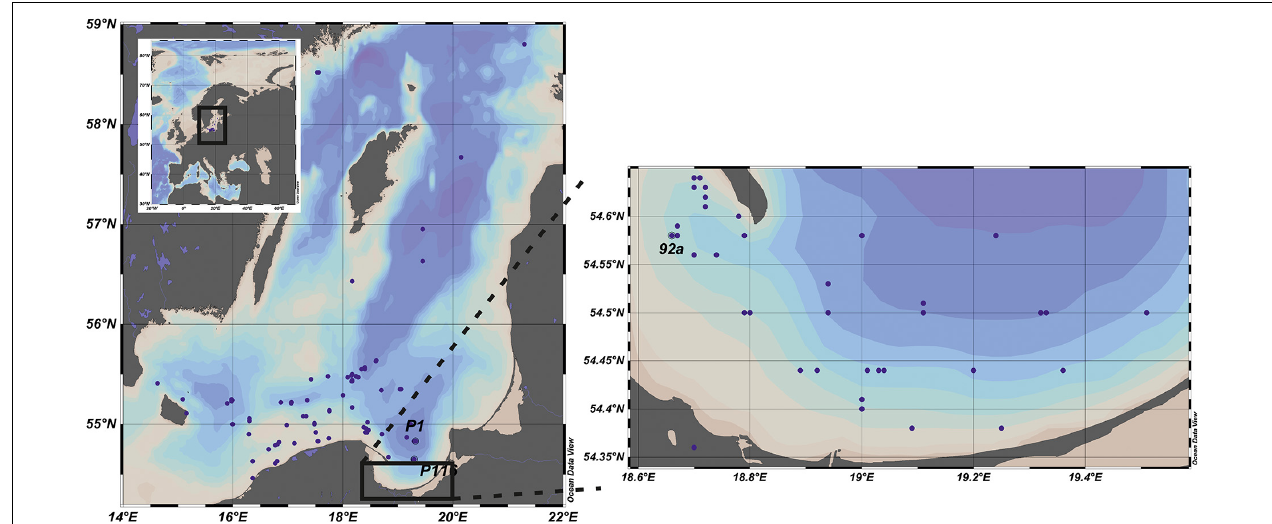
FIGURE 2 | The amount of data (AoD) collected in consecutive months (A) and years (B) within period 1993–2018.